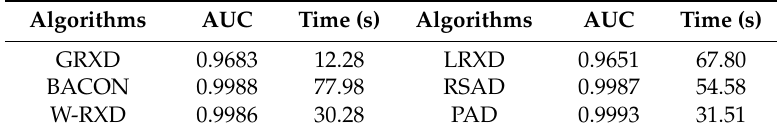
Table 4. AUCs and processing times (s) produced by the different detectors for the SpecTIR